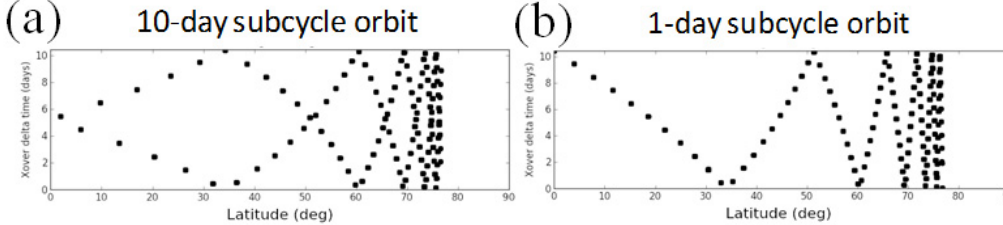
Figure 22. Distribution of the crossover delta-time as a function of latitude for the “nominal” SWOT orbit (a) and for the “backup” SWOT orbit (b). Unit: